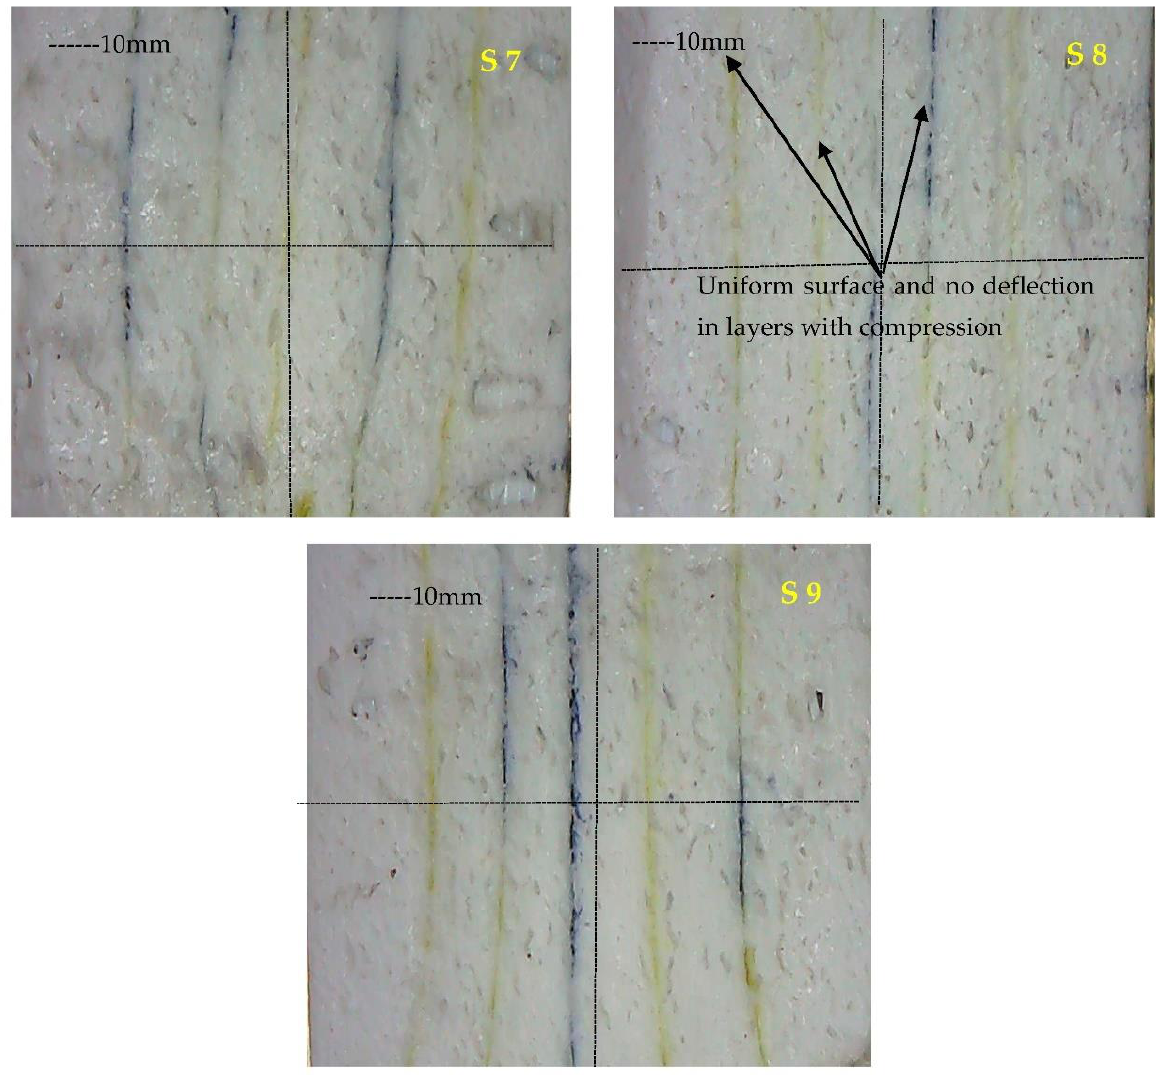
Figure 10. Tool Maker ’ s Microscopic images analysis for compression tested samples of laminated object manufactured 3D printed PLA.